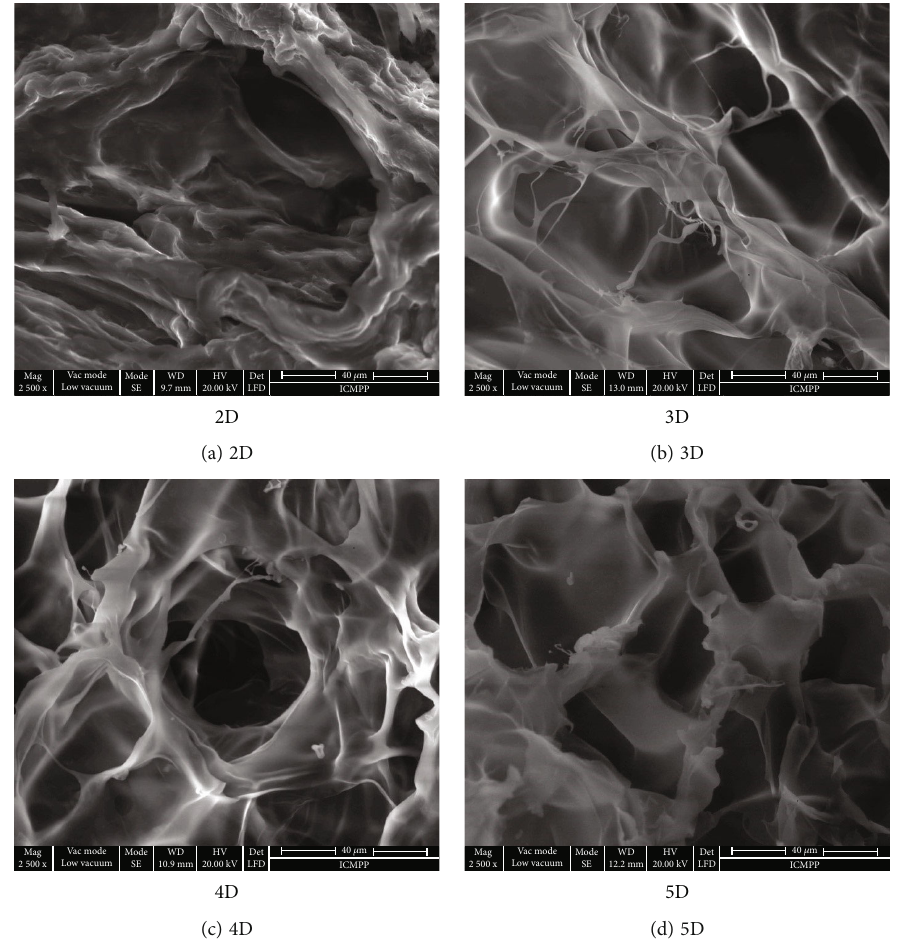
Figure 2: Microstructure of the studied formulations visualized by SEM.